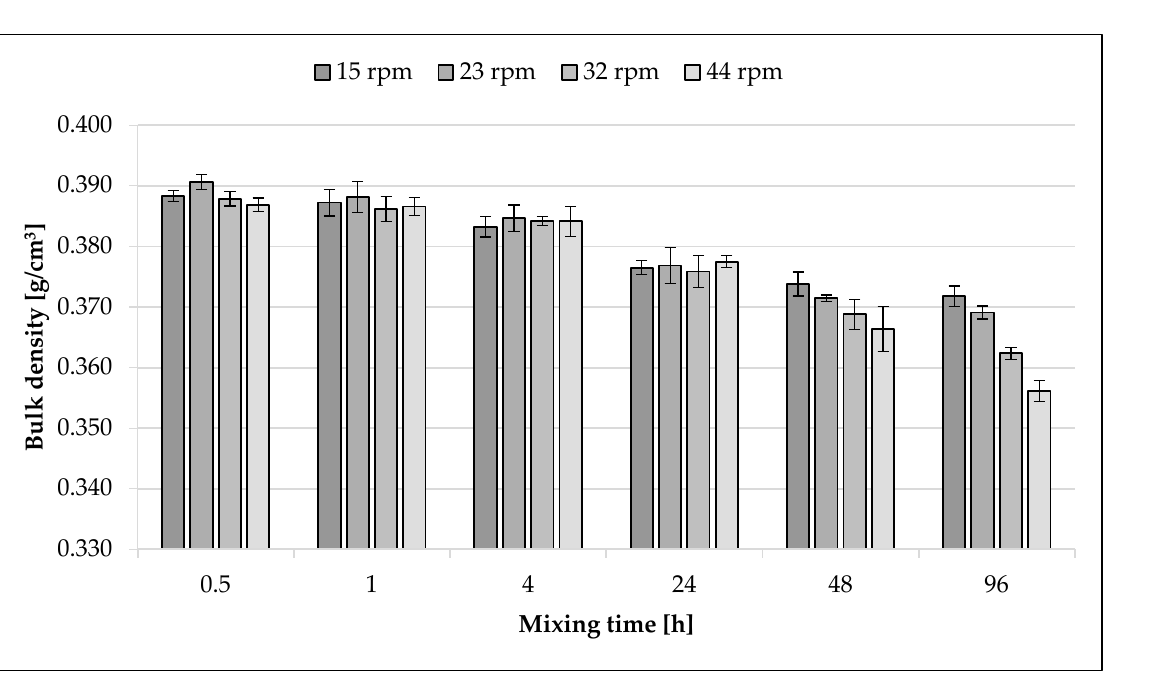
Figure 7. Influence of the mixing process (time and intensity) on the bulk density. Six mixing durations are considered, each with four mixing intensities.